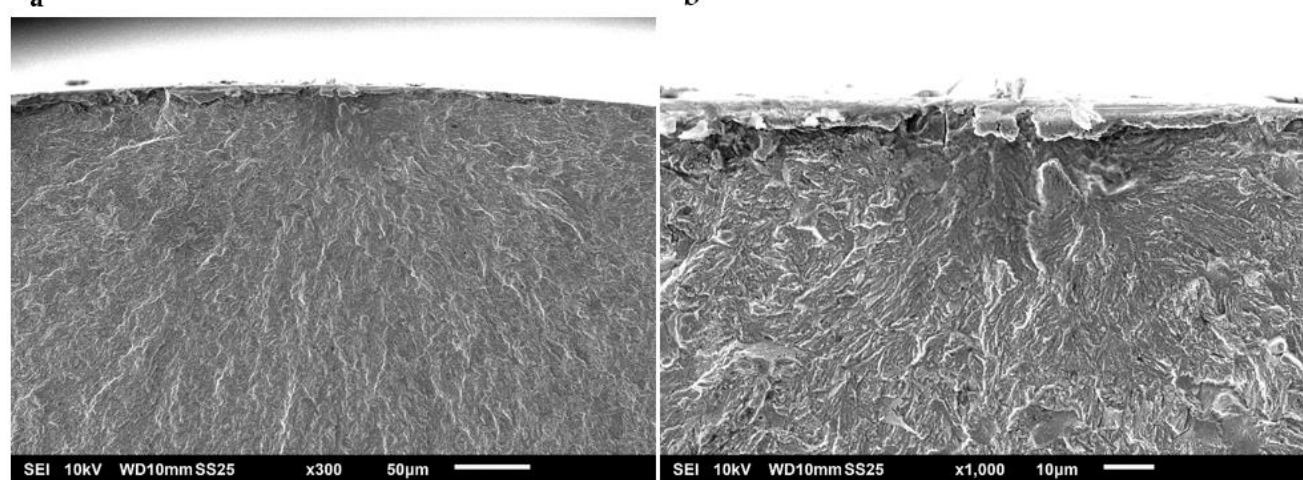
Figure 11. Surface crack initiation of a B-type steel specimen tested in air to a maximum stress of 1070 MPa (72% YS) at ( a ) x300 and ( b ) x1000.